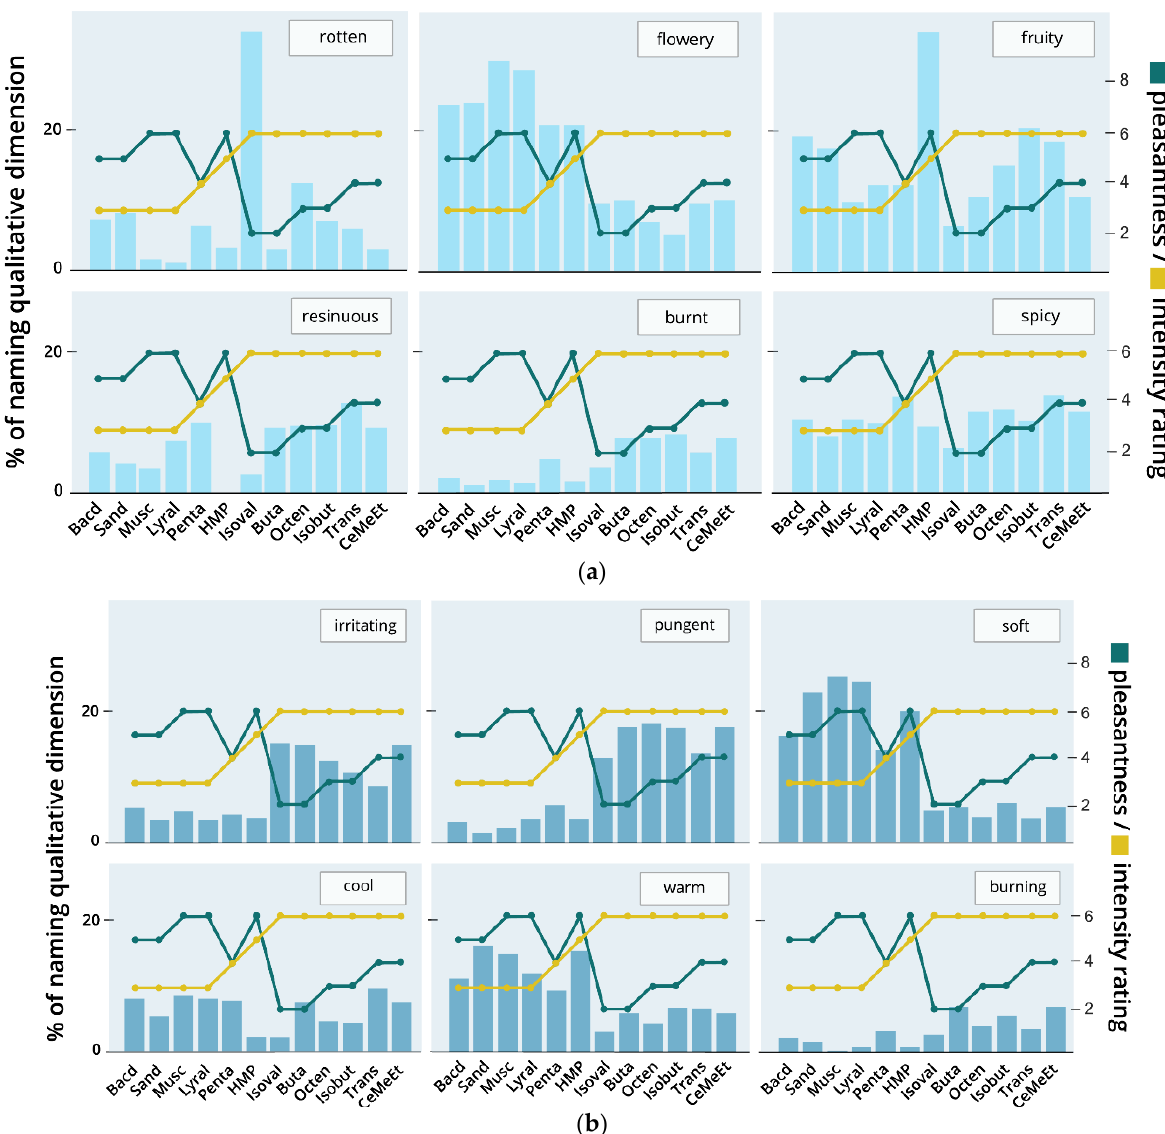
Figure 8. Qualitative Ratings. The figure shows the frequency (in %) of naming qualitative descriptors for each odor. The participants were asked to name the two descriptors that, in their opinion, fit best to each odor from a list of 12 qualitative descriptions (rotten, flowery, fruity, resinous, burnt, spicy, irritating, pungent, soft, cool, warm, burning; for details see Croy et al. [6]). Each subplot represents one of the qualitative descriptors, split into olfactory ( a ) and trigeminal ( b ) odor descriptions. To facilitate the discovery of associations between pleasantness, intensity and qualitative ratings, the median values for pleasantness and intensity are drawn as yellow and green lines in the plots.